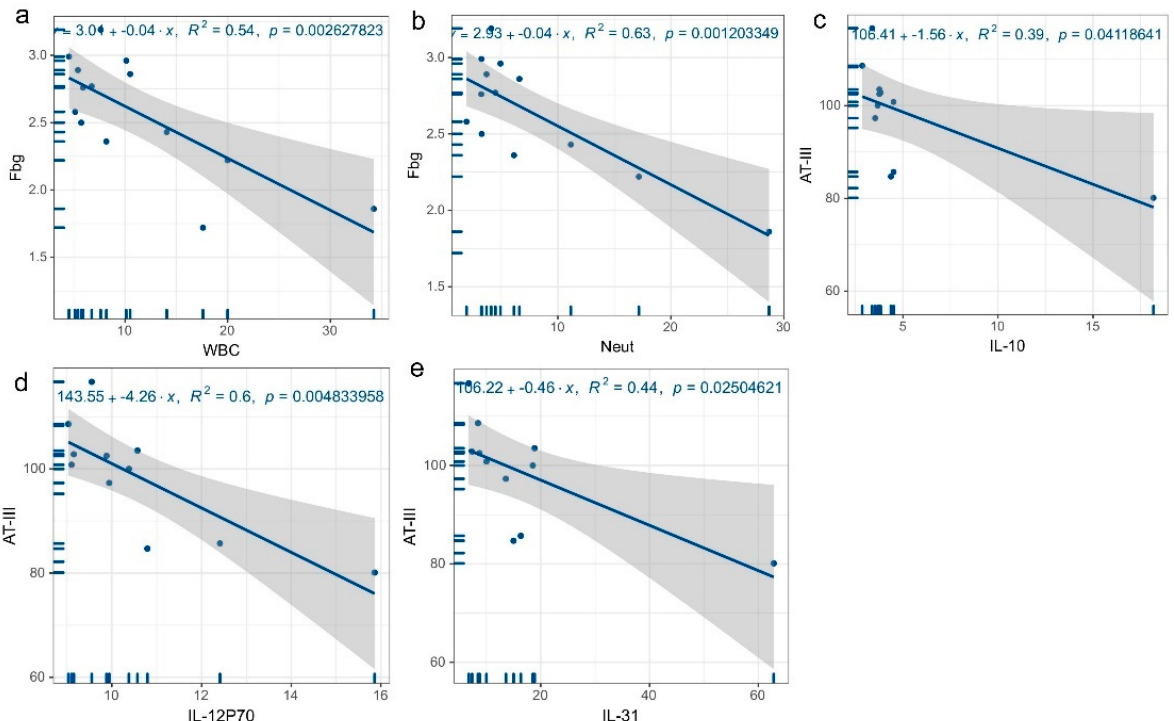
Figure 8. Regression plots of SELP-related indicators and coagulation factor levels. ( a ) Leukocyte count versus Fbg level, ( b ) neutrophil count concerning Fbg level, ( c ) IL-10 concerning AT-III level, ( d ) IL-12P70 concerning AT-III level, ( e ) IL-31 concerning AT-III level.